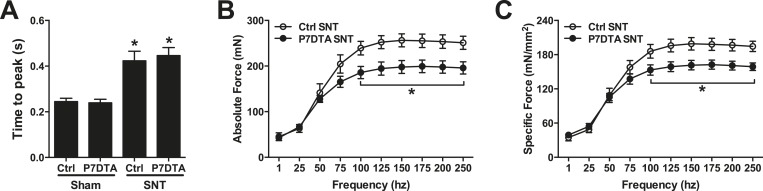
SC depletion leads to declines in force generation of skeletal muscles after neuromuscular disruption.(A) Average time to peak tension (TTP) during 150 Hz stimulation in EDL muscles. *p < 0.05 compared to Ctrl and P7DTA sham. ANOVA/Bonferroni multiple comparisons test, N = 4–6. (B) Absolute and (C) Specific force frequency curves for Ctrl and P7DTA EDL muscles 6 weeks after SNT surgery. *p < 0.05 compared to Ctrl SNT at indicated frequency, t-tests, N = 4–6 mice.